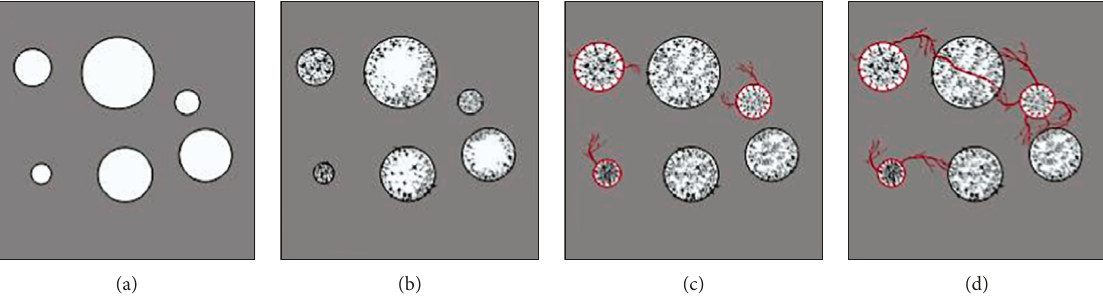
Figure 17: The pore evolution rules of concrete specimens exposed to drying-wetting cycles with sulfate attack. (a) Initial stage, (b) filling stage, (c) expanded stage, and (d) connected stage.